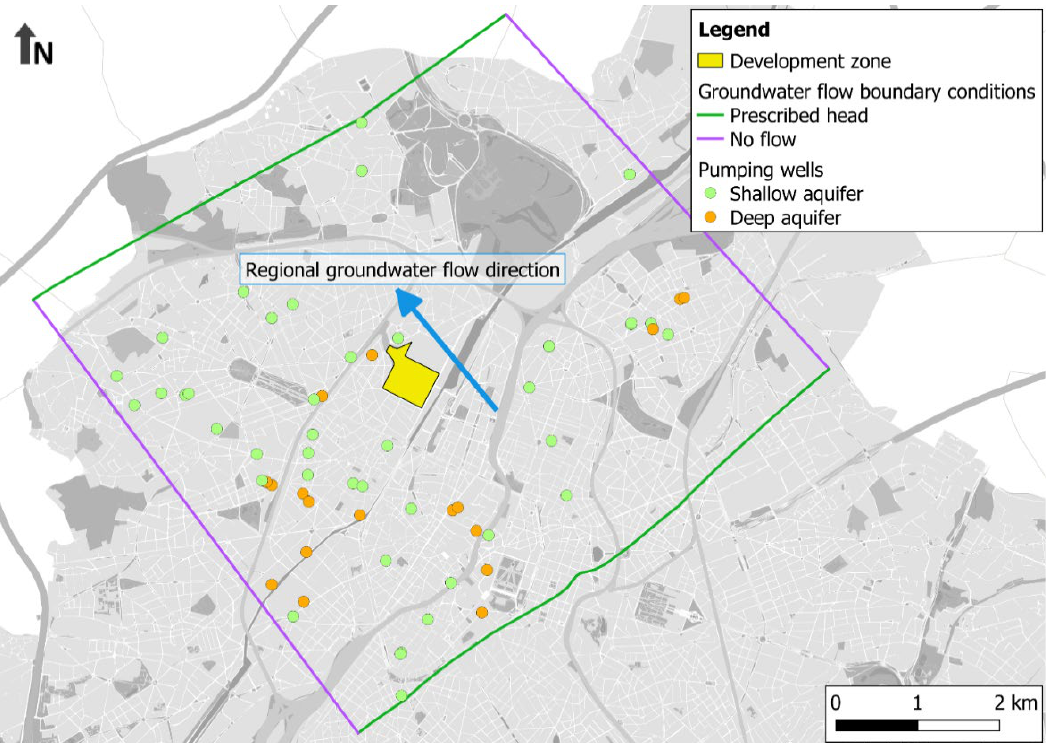
Figure 4. Lateral boundaries for solving the groundwater flow. Lateral BCs for heat transport are everywhere prescribed to the natural initial temperature of 12.4 °C. Blue and green dots are pumping wells in the shallow and deep aquifers respectively, and the blue arrow shows the direction of the regional groundwater flow.